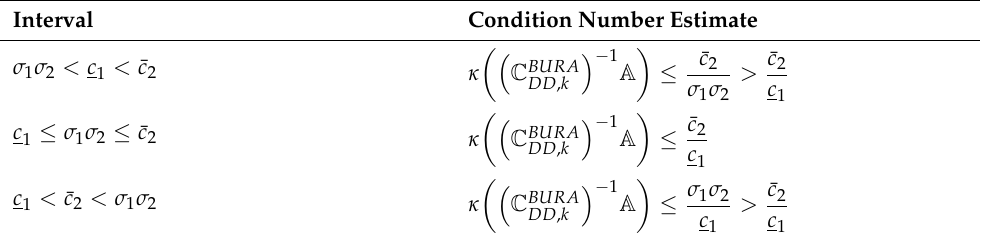
Table 2. Dependence of the estimate of κ